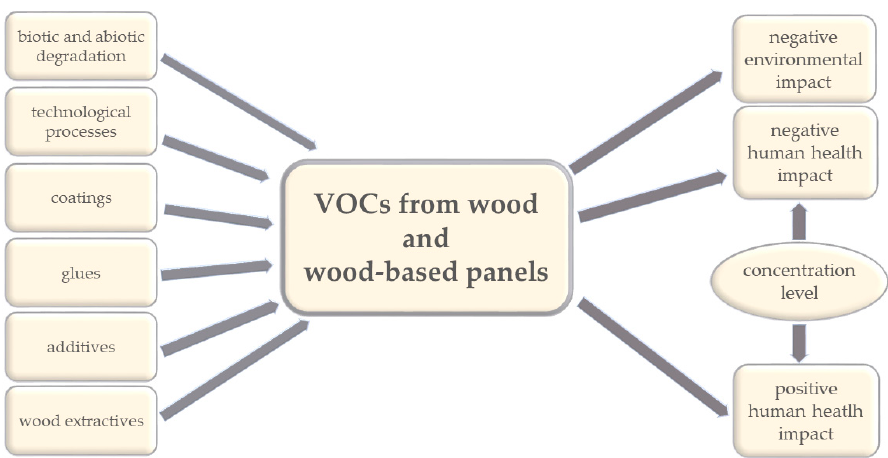
Figure 1. Volatile organic compounds (VOCs) from wood and wood-based panels: their sources and impact.